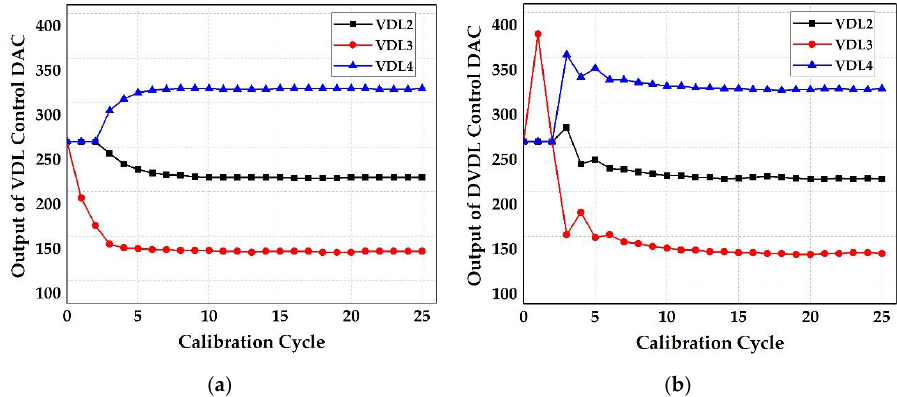
Figure 14. Convergence process of VDL control DAC output ( a ) when fin = 141 MHz and ( b ) when fin = 1.3 GHz.